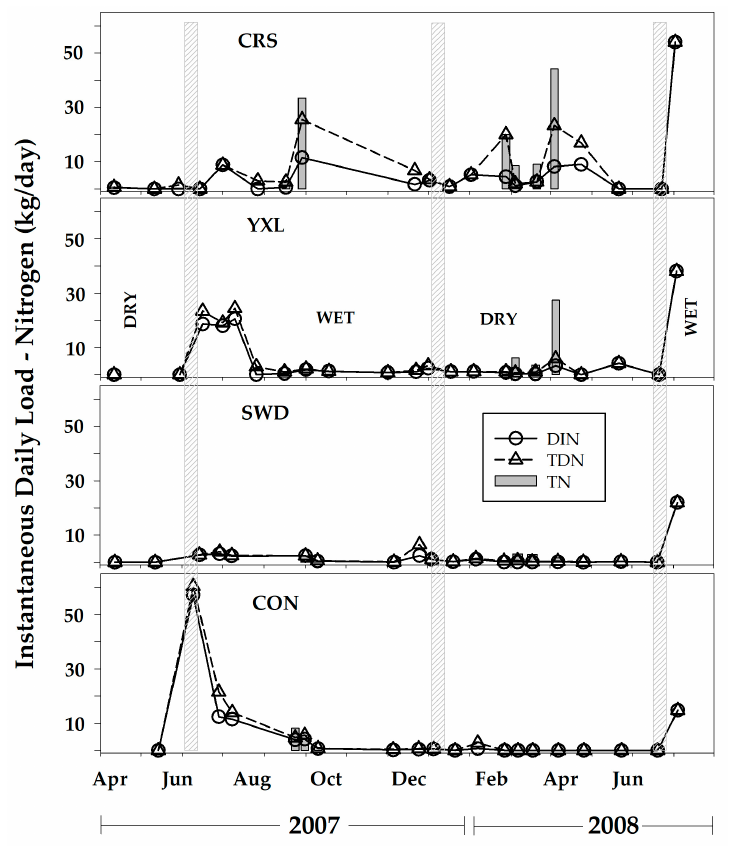
Figure 6. Daily nitrogen fluxes from the study catchments.